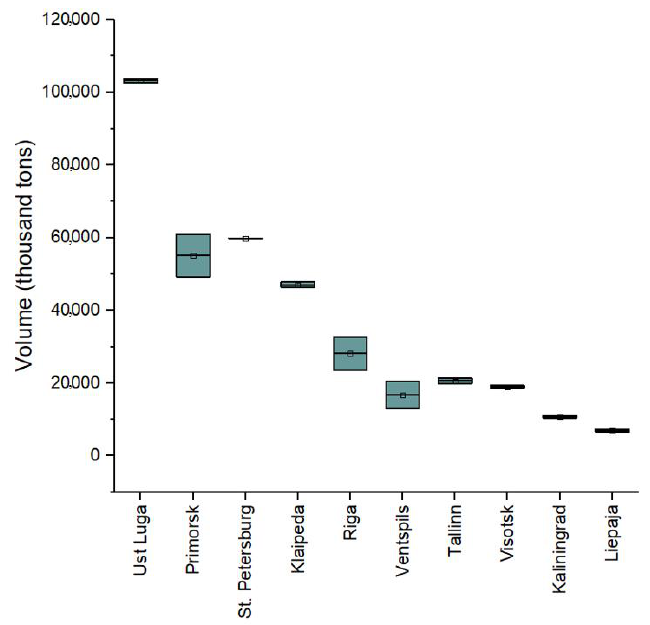
Figure 23. Distribution of cargo flows in ports of the eastern Baltic coast in 2015 – 2019 (before the COVID-19 pandemic).